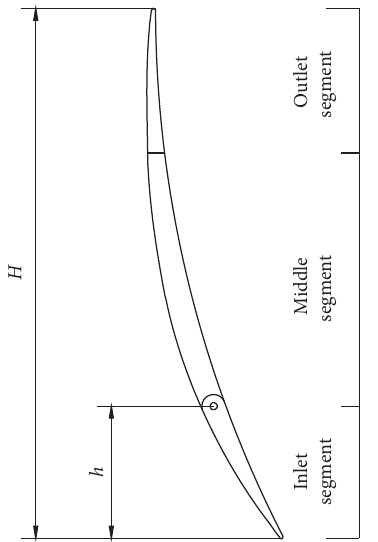
Figure 5: Segmentation of the guide